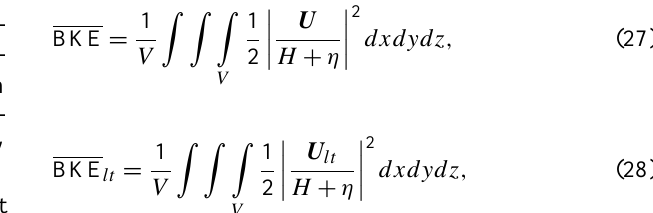
in (a) TIDE and (b) TIDEa1. The contour RMSE